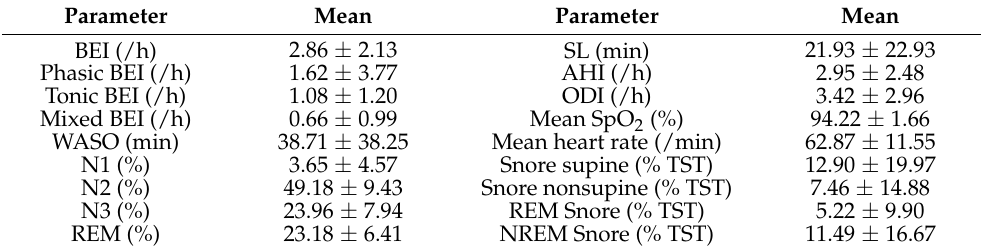
Table 2. Polysomnographic parameters determined in the study group ( n =